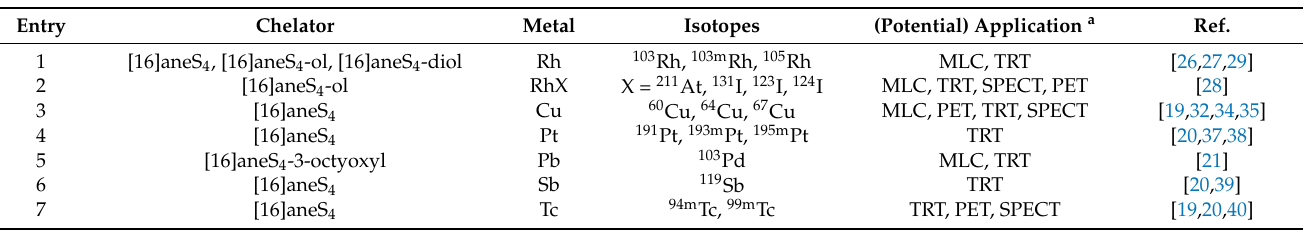
Table 1. Overview of selected reported metal [16]aneS 4 –ligand complexes (MLC) and their potential application in radionuclide diagnostics or therapy, see SM for a more detailed overview. Both reported radionuclides and relevant unreported radioisotopes of the same element are